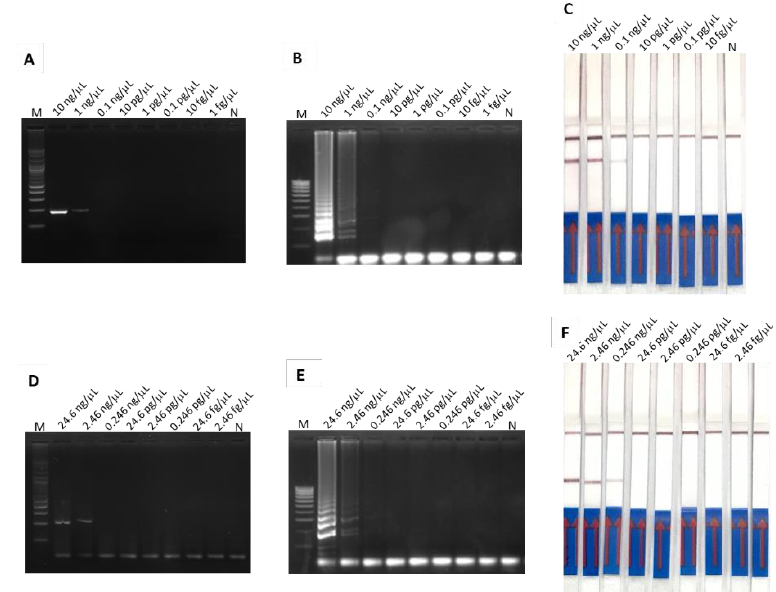
Figure 3. The LOD of PEDV spike gene amplification determined using ( A ) RT-PCR-AGE, ( B ) RT- LAMP-AGE and ( C ) RT-LAMP-LFD. The LOD of PCV2 ORF gene amplification examined using ( D ) PCR-AGE, ( E ) LAMP-AGE and ( F ) LAMP-LFD. ( D ) PCR-AGE, ( E ) LAMP-AGE and ( F )